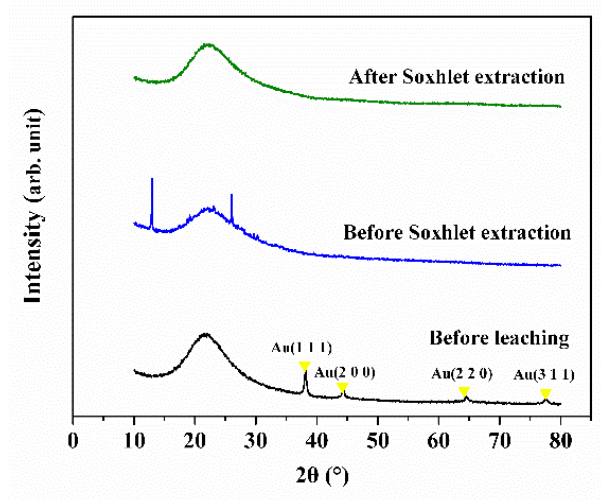
Figure 9. XRD spectra of catalysts in different stages.